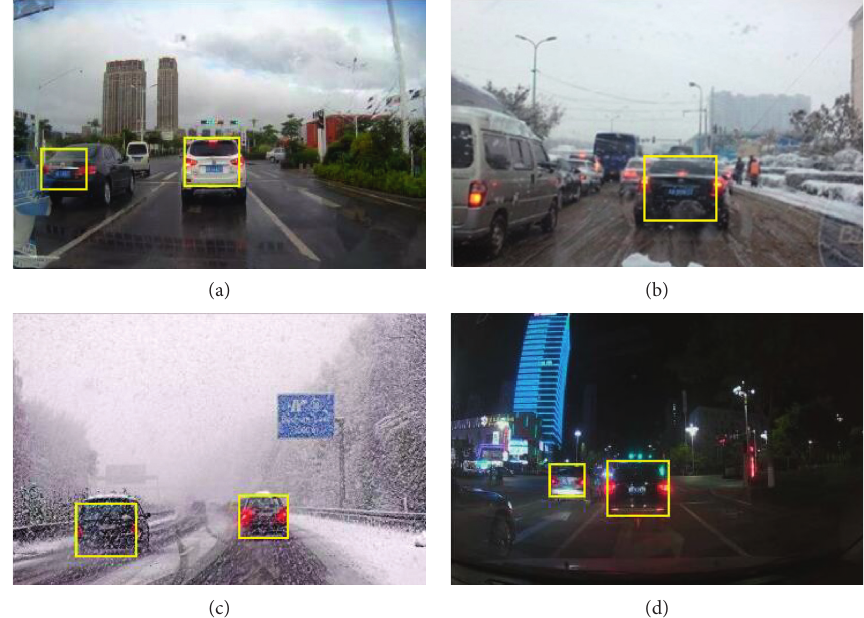
Figure 12: Vehicle detection results under rain, snow, and night conditions. (a) Vehicle detection results under rainy weather conditions. (b) Vehicle detection results in snowy weather under urban road conditions. (c) Vehicle detection results in snowy weather under highway conditions. (d) Vehicle detection results under night environment.